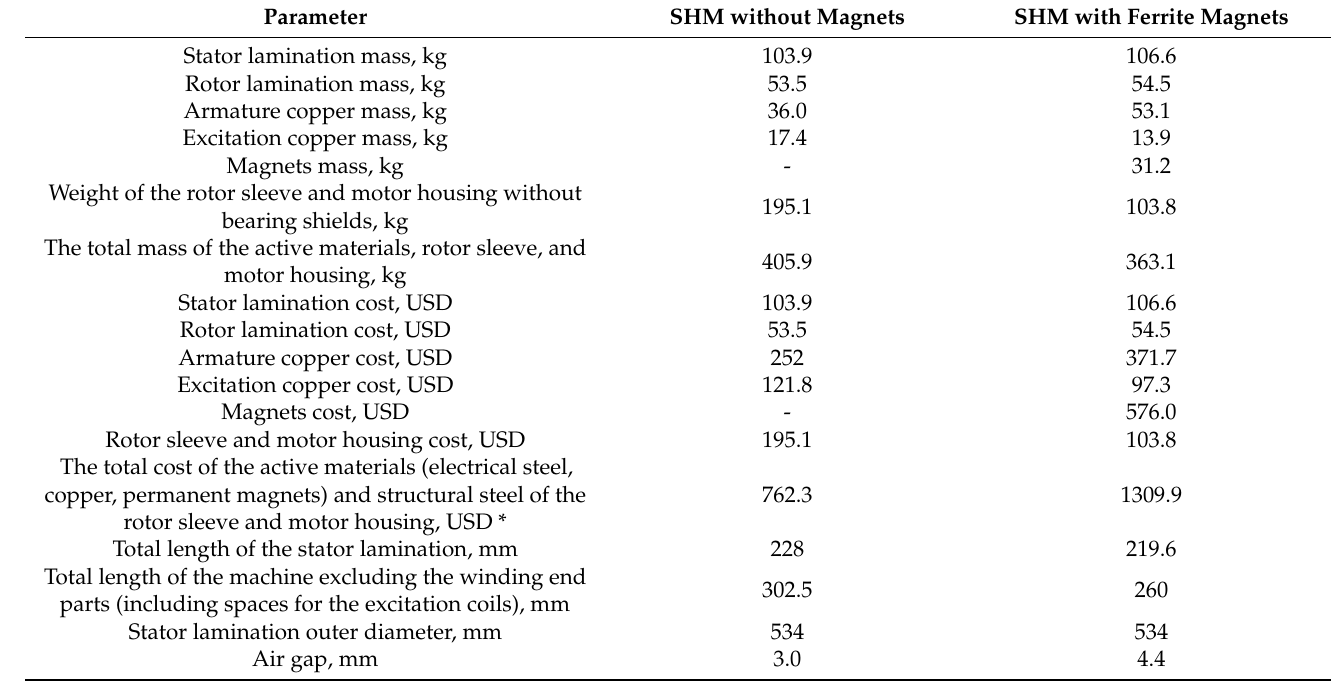
Table 7. Comparison of masses, costs, and dimensions of parts of the SHM without magnets and with ferrite